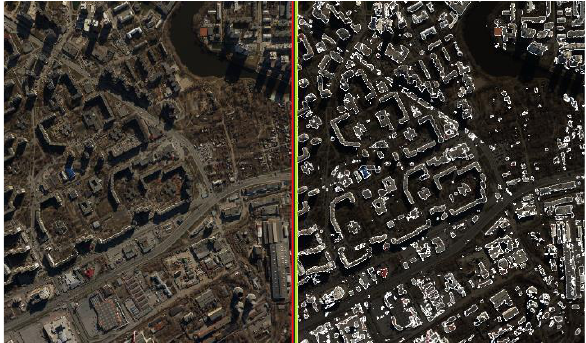
Figure 3 . The original aerial photo (left) and the same photo with the superimposed mask (right)